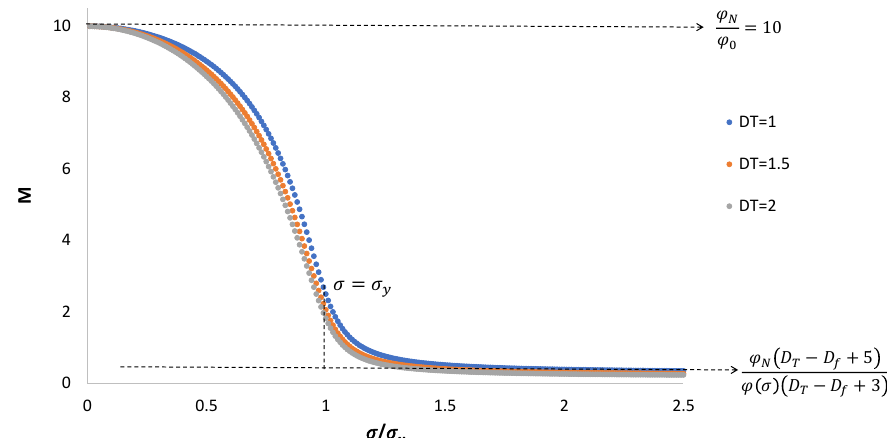
ϕ N = 0.2. At the K 3 ϕ ∞